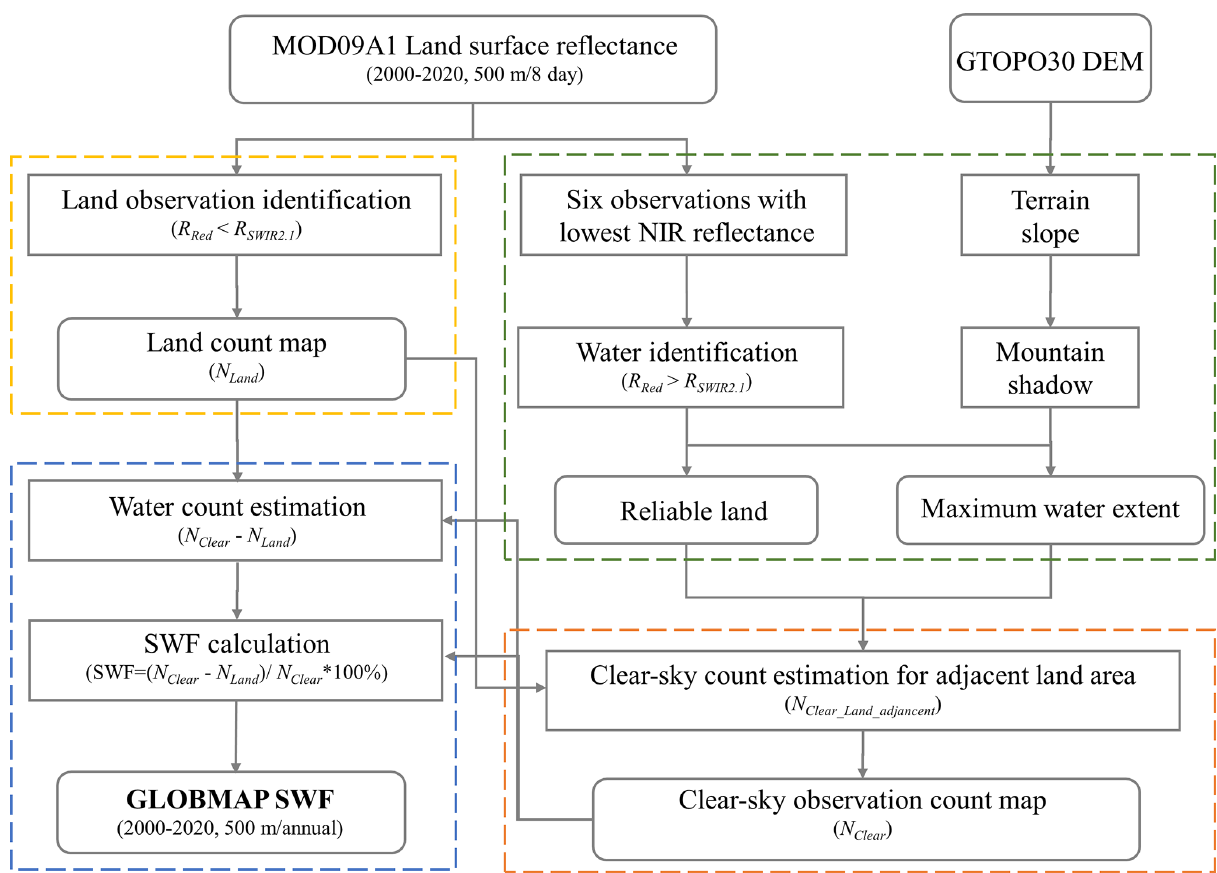
Figure 1. Workflow of the method for generating the GLOBMAP surface water cover frequency